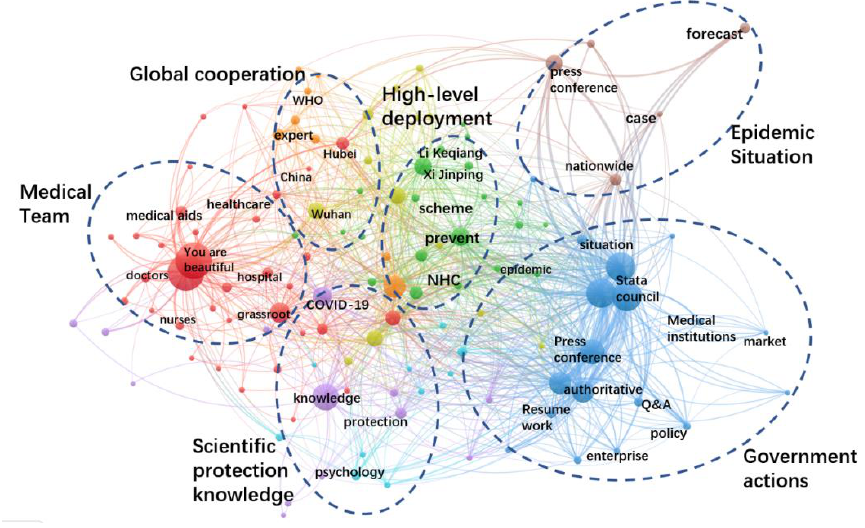
Figure 8. Keywords co-occurrence network of government information supply in the control stage.